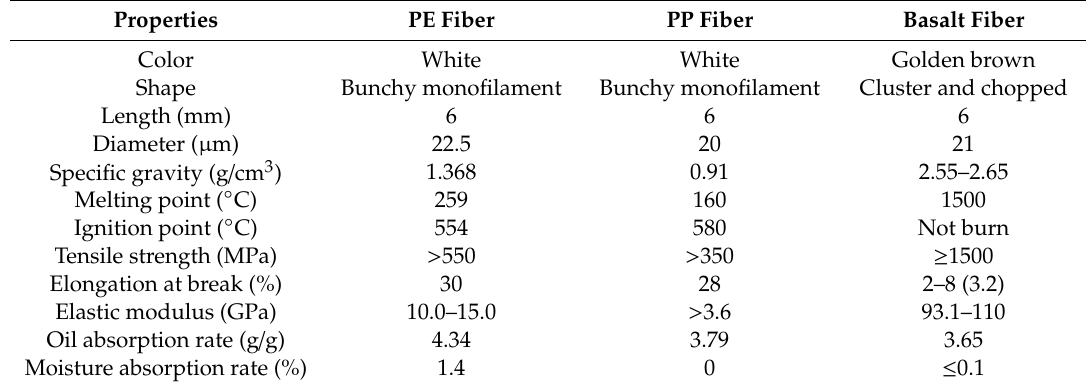
Table 5. Properties of fibers.